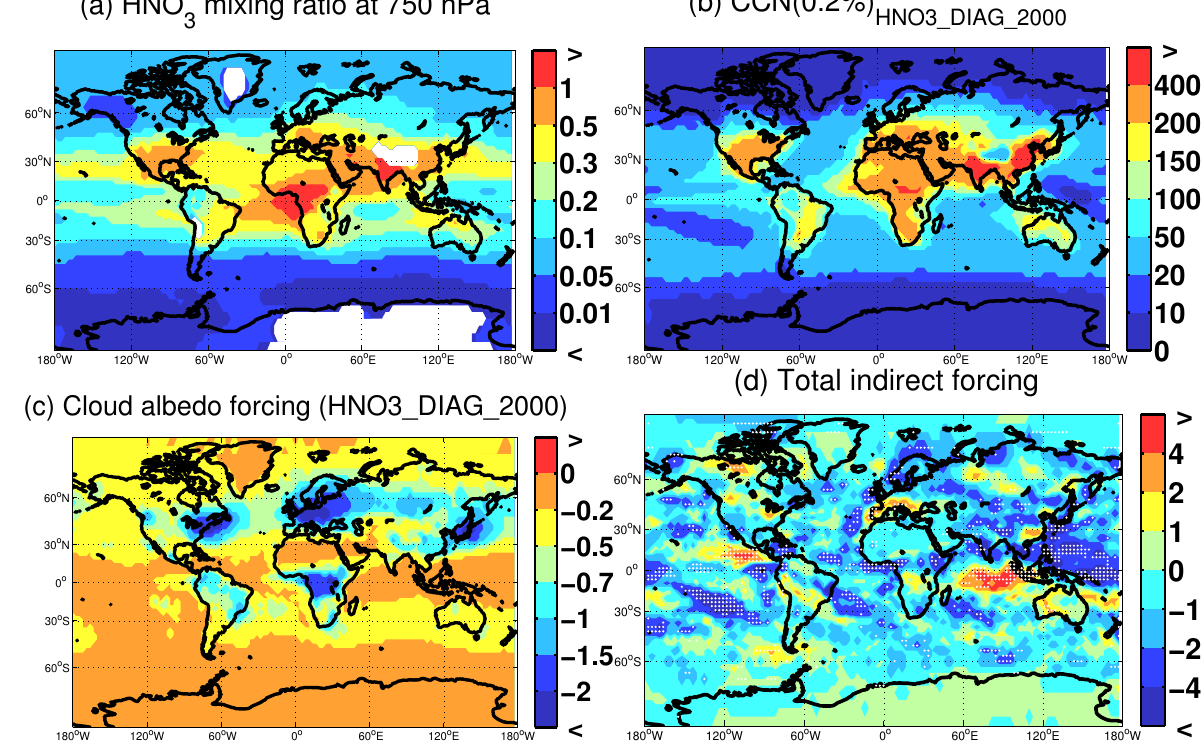
Fig. 4. (a) Annual average nitric acid mixing ratio at 750hPa (ppb), (b) surface-level CCN(0.2%) (cm − 3 ) from experiment HNO3 DIAG 2000 (unperturbed by nitric acid), (c) cloud albedo forcing (Wm − 2 ) (experiment HNO3 DIAG 2000) and (d) total indi- rect forcing (Wm − 2 ) due to inclusion of nitric acid, calculated from experiments HNO3 2000 and CTRL 2000. The cloud albedo forcing is averaged over 5yr, the total indirect forcing over 20yr. White dots in (d) indicate statistical significance with p < 0 .